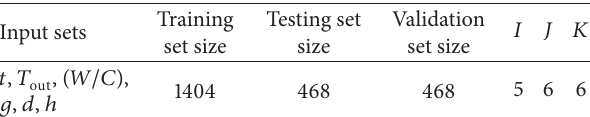
Table 3: Details of ANN model.